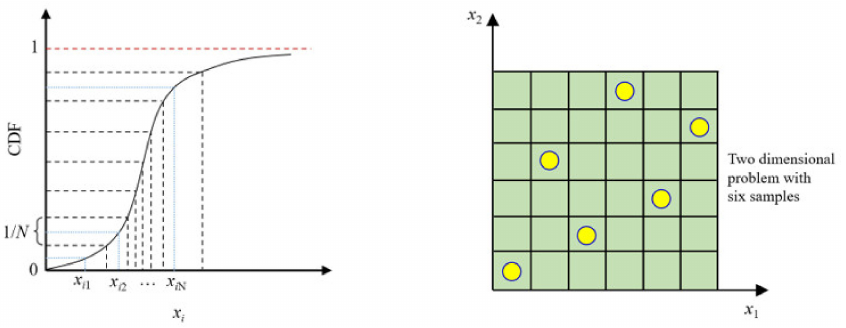
Figure 4. Basic principles of the Latin hypercube sampling method.